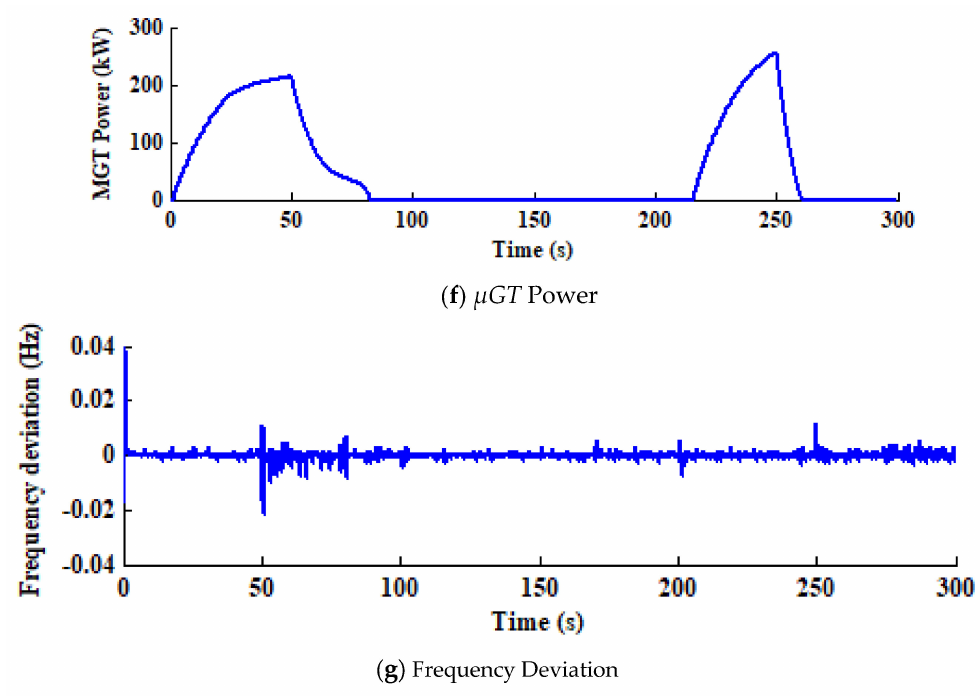
Figure 11. The simulation results for scenario 2.